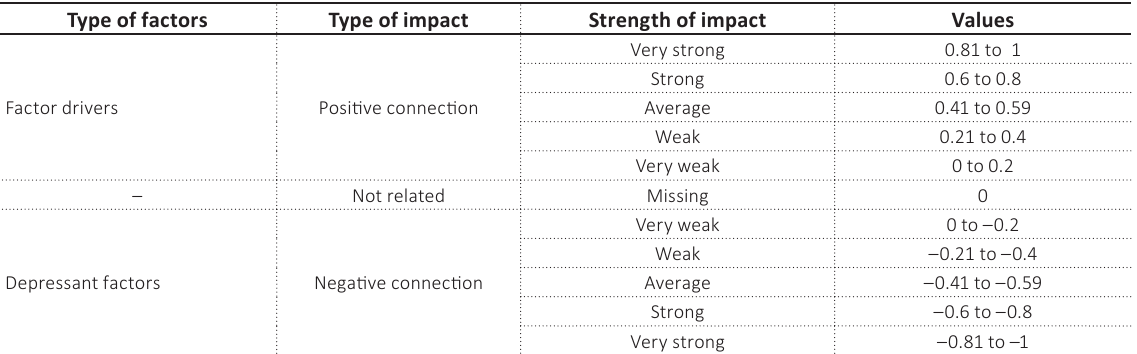
Source: Stylios and Groumpos (1999).